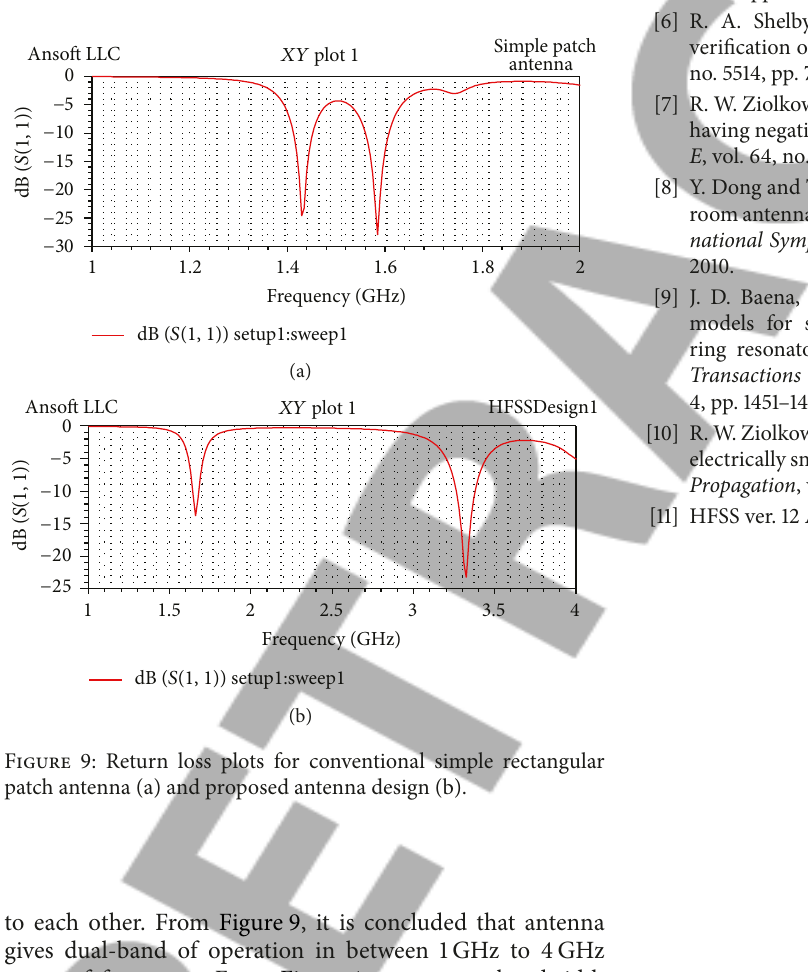
Figure 9: Return loss plots for conventional simple rectangular patch antenna (a) and proposed antenna design